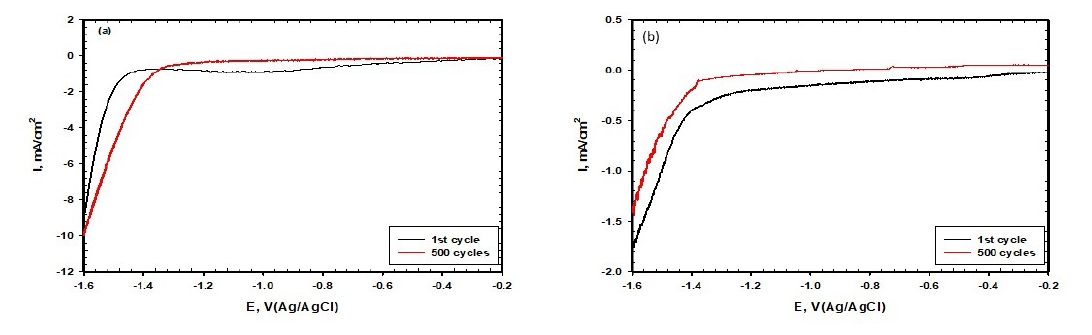
Zn Fe O prepared by solid state method at 800 o C and (b) Co 0.8 0.2 2 4